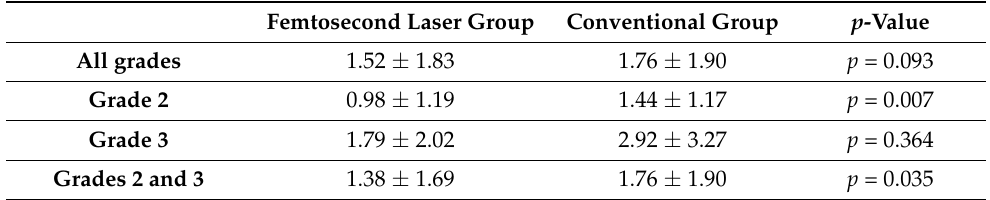
Table 5. EPT in seconds by cataract grade